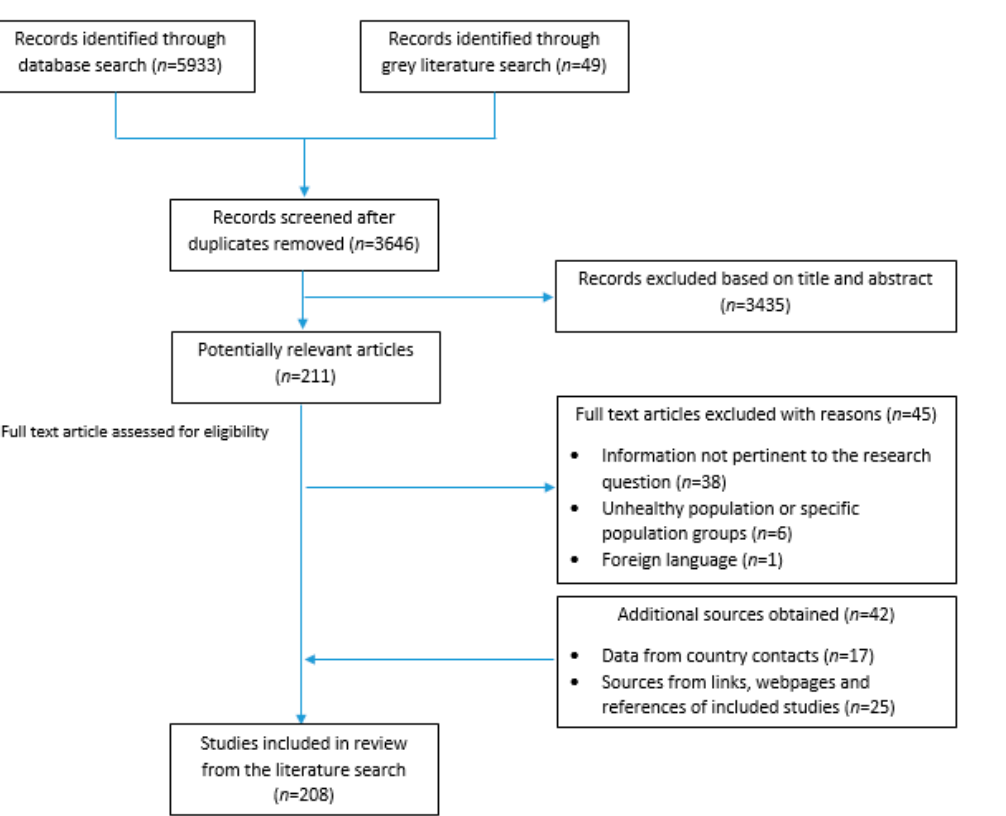
Figure 1. Search and identification process of potential references from the literature.